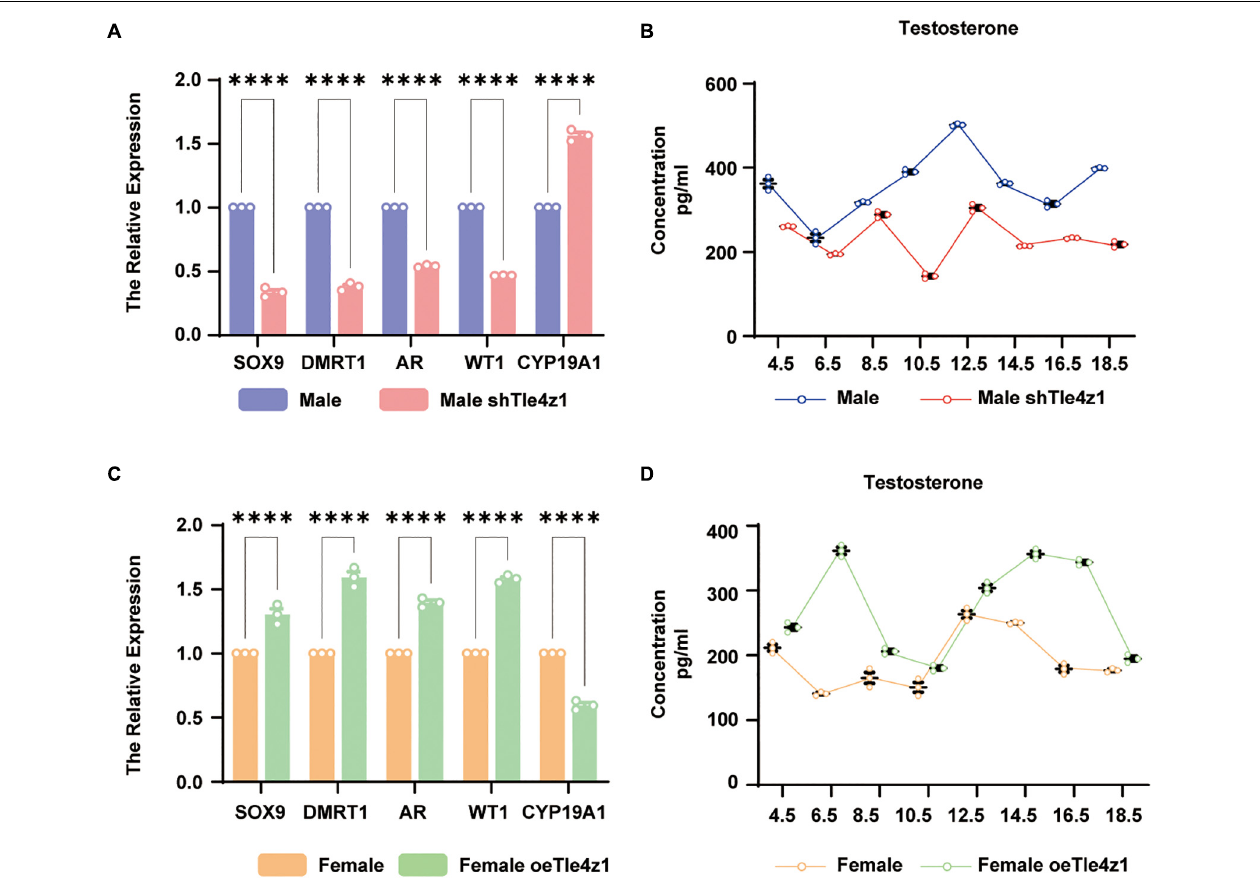
FIGURE 4 | Tle4z1 promotes the sex differentiation of chicken embryos into males at mRNA and hormone levels. (A) Relative expression of sex-related genes (Sox9, DMRT1, AR, WT1 and CYP19A1) in male interference group at E18.5 by qRT-PCR. ∗∗∗∗ P < 0.0001, values are means ± SEM. n = 3. (B) Changes in the expression of testosterone in male interference group at E4.5, E6.5, E8.5, E10.5, E12.5, E14.5, E16.5, and E18.5 was detected by ELISA. (C) Relative expression of sex-related genes in female overexpression group at E18.5 by qRT-PCR. (D) Changes in the expression of testosterone in female overexpression group at E4.5, E6.5, E8.5, E10.5, E12.5, E14.5, E16.5, and E18.5 was detected by ELISA.